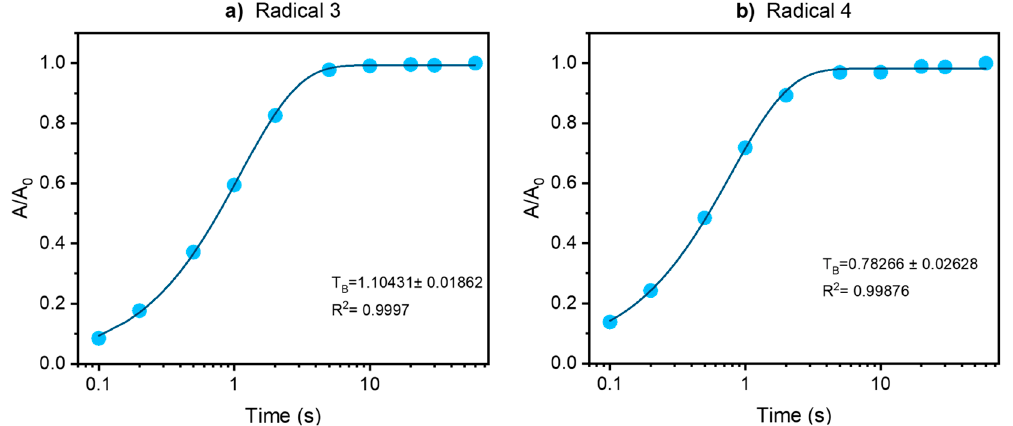
Figure 4. 1 H build-up curves obtained for frozen solutions of radical 3 ( a ) and 4 ( b ) in glycerol- d 8 /D 2 O/H 2 O (60:30:10 v/v/v). A mono-exponential function was used to fit the data points.